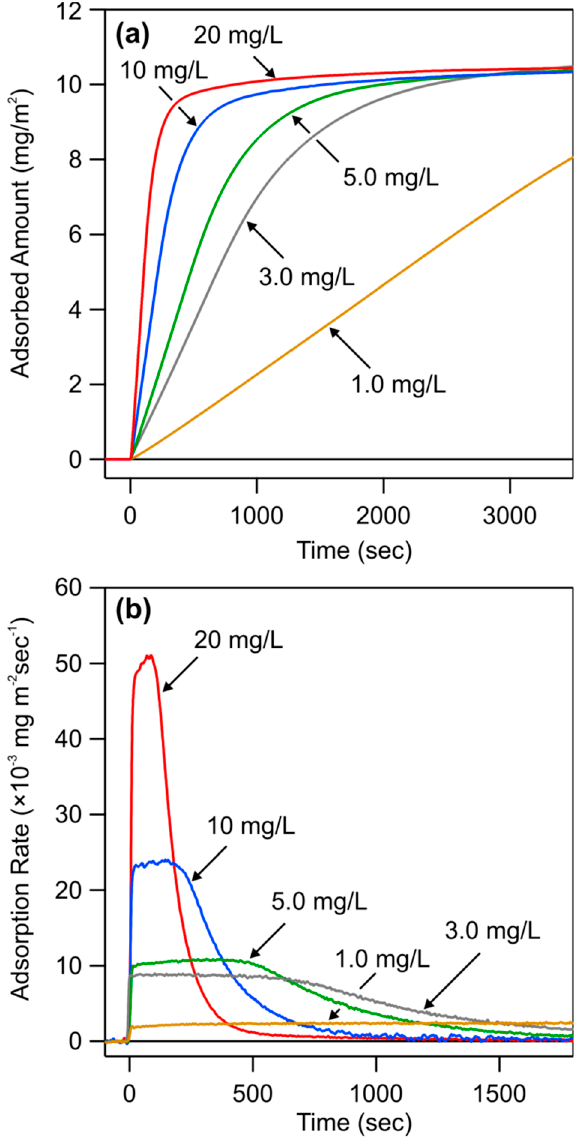
Figure 8. Deposition process of nanoparticles on the PDADMAC-functionalized silica at pH 4.0 and an ionic strength of 10 mM for various concentrations of nanoparticles. ( a ) The deposited amount and ( b ) the time-derivative of the deposited amount are represented as a function of time.